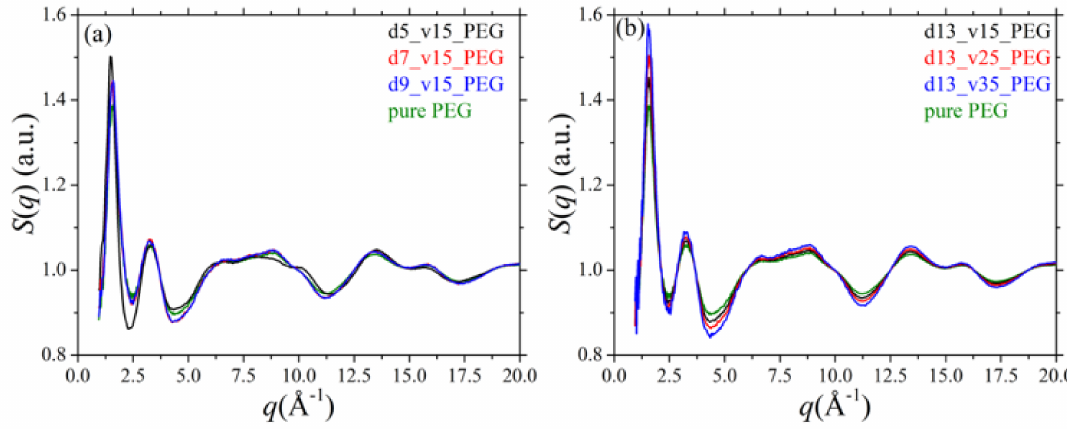
Figure 5. Simulation predictions for the static structure factor S ( q ) ( T = 413 K and p = 1 atm) and dependence on: ( a ) silica diameter, and ( b ) silica volume fraction. In all cases, the green curve corresponds to the result obtained for the pure PEG melt (system 1) at the same thermodynamic